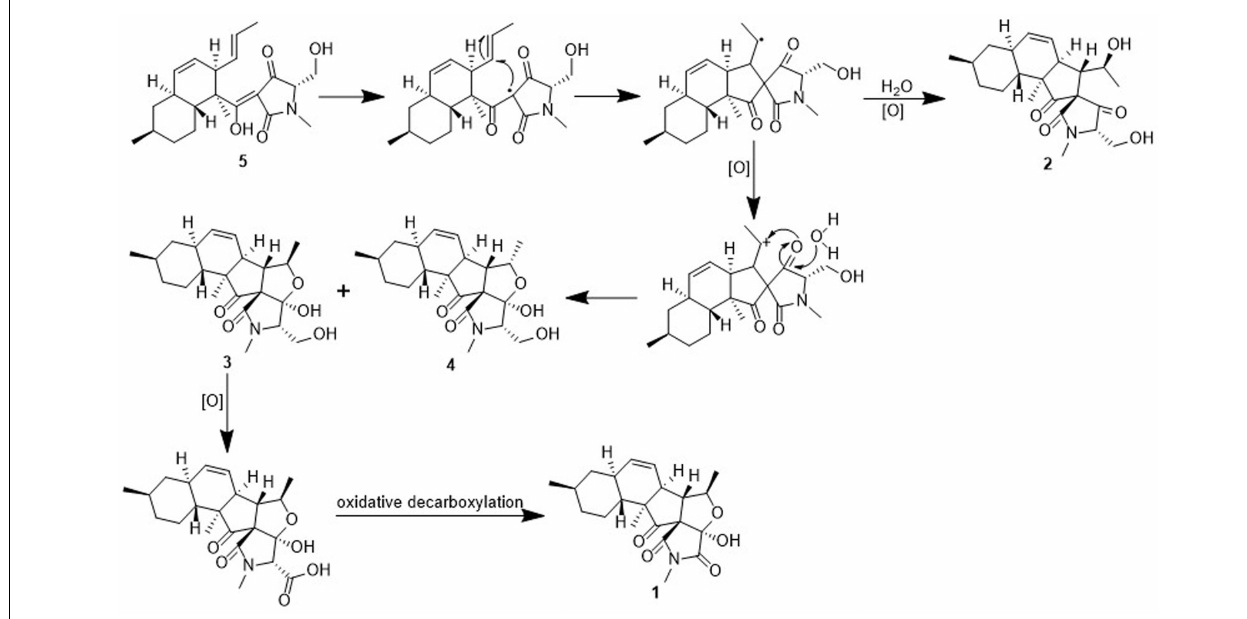
FIGURE 6 | Proposed biosynthetic pathway of compounds 1 - 4 . TABLE 3 | Anti-phytopathogenic bacterial and fungal activities of 5 and 6